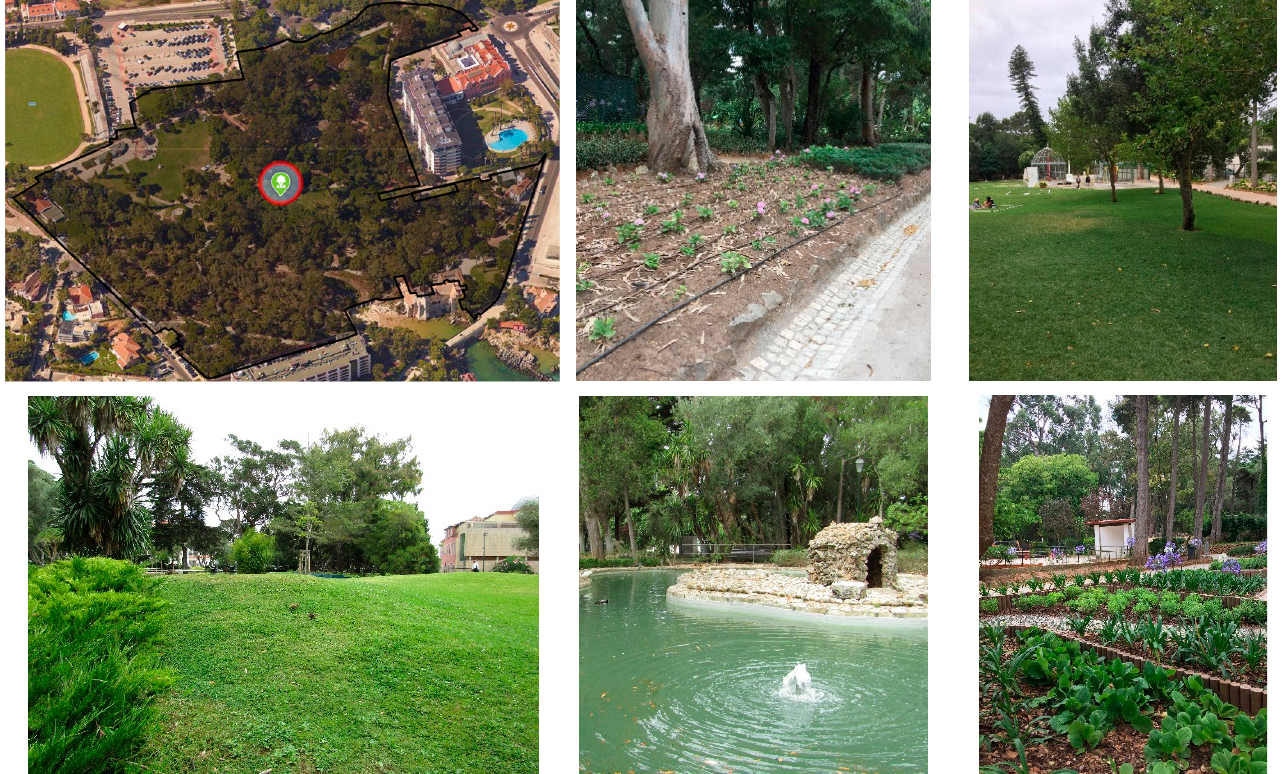
Figure 4. Case study 2: landscape and system boundaries.